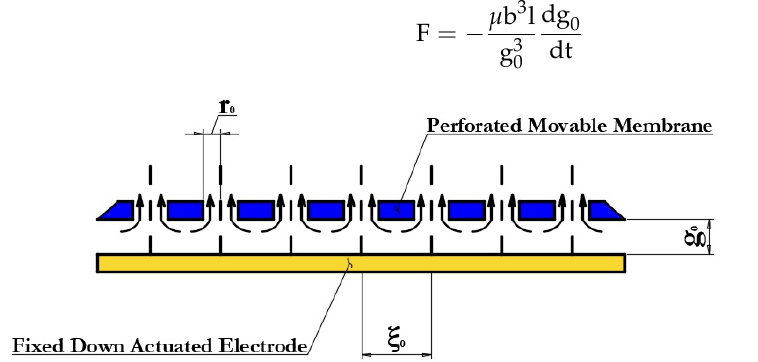
Figure 13. Schematic view of the air flow under movable